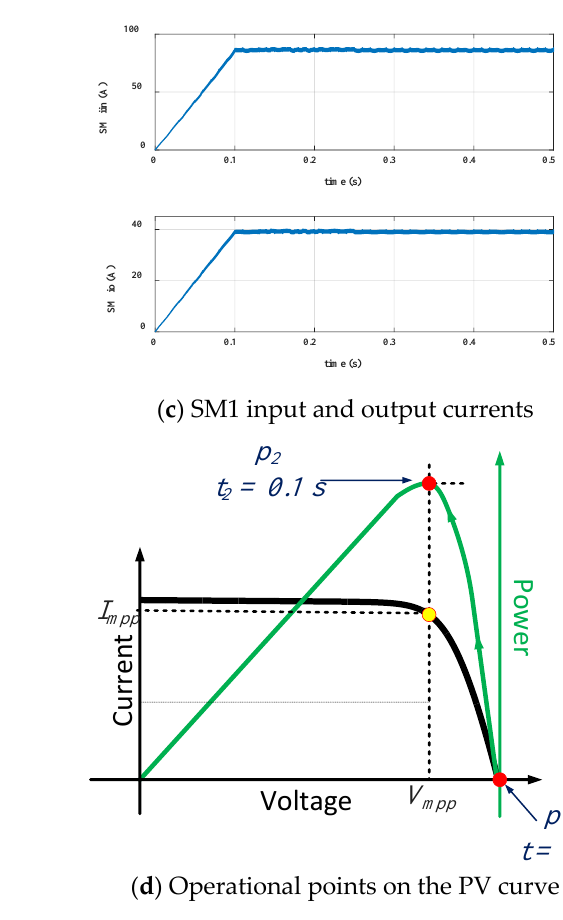
Figure 16. Mode 2 (from PV modules to batteries) MATLAB/SIMULINK simulations.